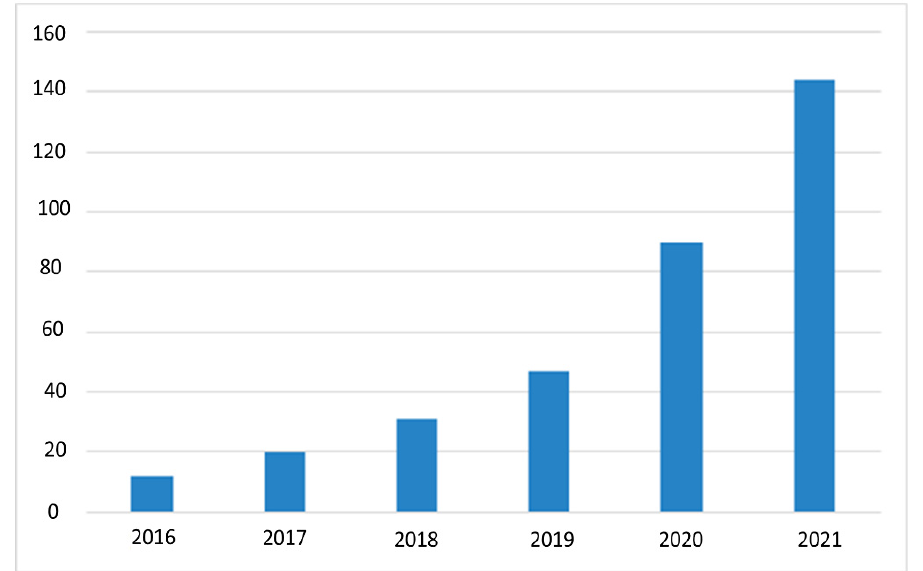
Figure 1. A demonstration of research efforts on MFR from 2016 to 2021.